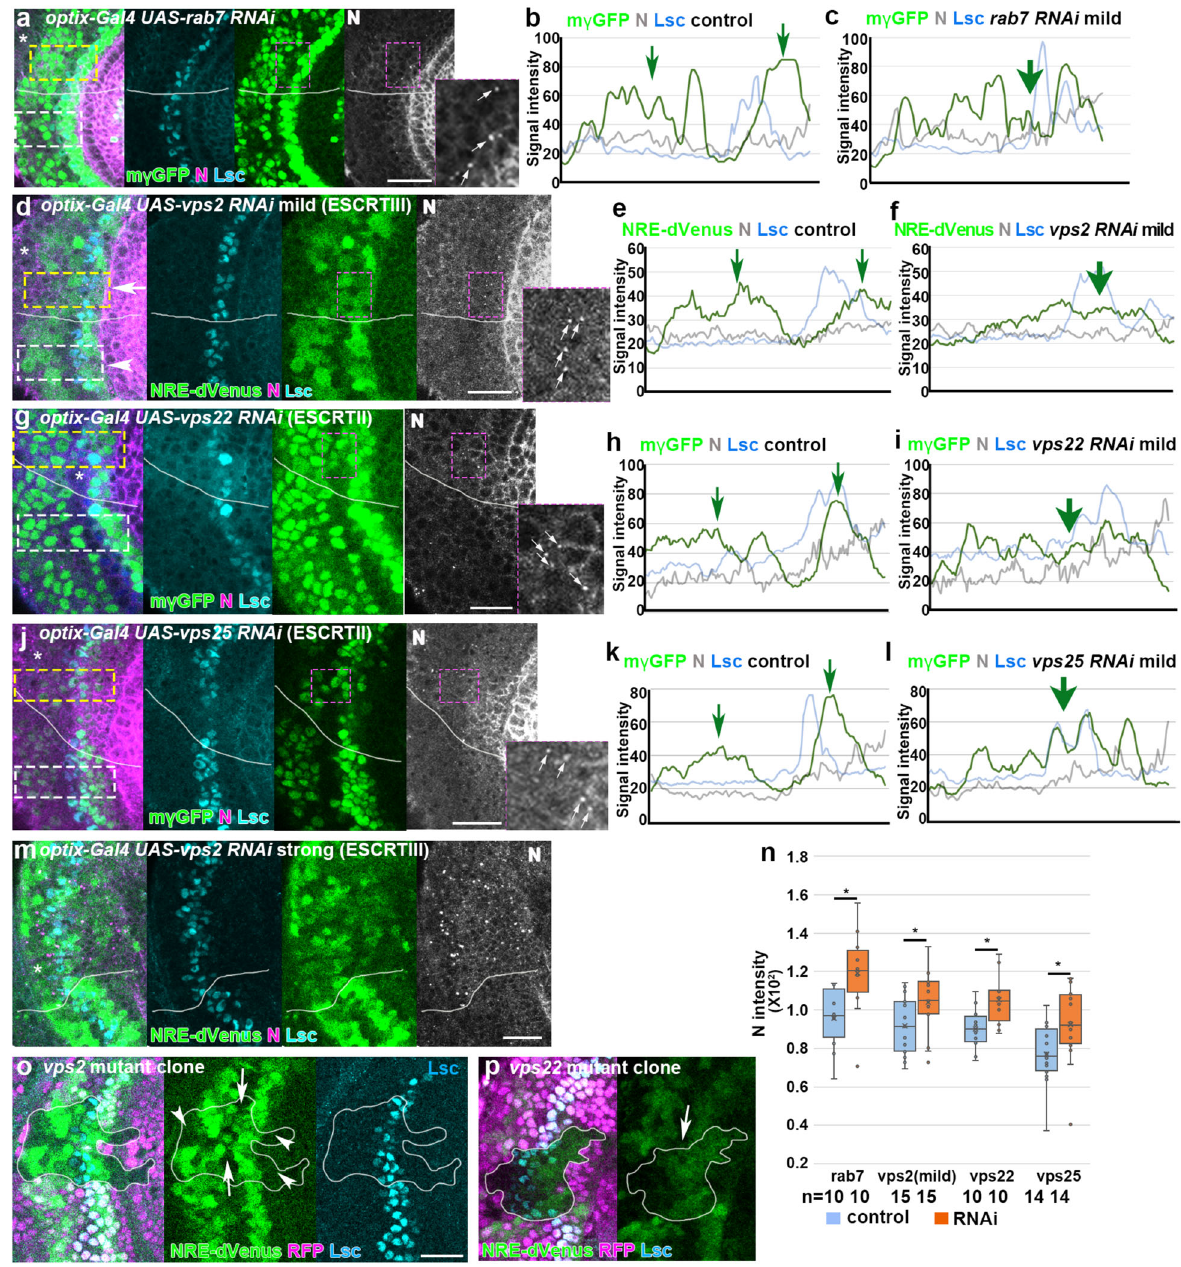
Fig. 5 Late endosomes are responsible for Notch inactivation at the wavefront. a – l RNAi knockdown of rab7 ( a ), vps2 ( d ), vps22 ( g ), and vps25 ( j ) under the control of optix-Gal4 induces ectopic puncta of N (magenta or white, arrows) and fusion of the twin activation peaks of N (m γ GFP in a , g , j and NRE- dVenus in d , green) at the wavefront (Lsc, blue). The magenta dotted boxes are magni fi ed in the right panels showing the ectopic puncta of N. Asterisks indicate the optix-Gal4 positive areas outlined by white lines. The signal intensities of N activity (green), N expression (gray), and Lsc (blue) within the white and yellow dotted boxes in ( a , d , g , j ) are plotted in ( b , e , h , k ; controls) and ( c , f , i , l ; RNAi), respectively. Green arrows indicate the N activity peaks. m vps2 RNAi with a strong phenotype induces ectopic N puncta (magenta and white) and uniform N activity (NRE-dVenus, green) in a wide area (asterisk). Lsc (blue). n Quanti fi cation of N intensity ( p = 0.020, 0.047, 0.017, 0.038 (* p < 0.05), two-sided t test). Numbers of quanti fi ed areas are indicated. Cross, mean; center line, median; box limits, upper and lower quartiles; whiskers, 1.5× interquartile range. o , p Fusion of the twin peaks of N activity (NRE-dVenus, green) in vps2 and vps22 mutant clones, respectively, visualized by the absence of RFP (magenta). Arrows indicate the upregulation of N activity between the twin peaks. Arrowheads indicate the absence of N activation in cells adjacent to the wavefront (Lsc, blue). Scale bars indicate 20 μ